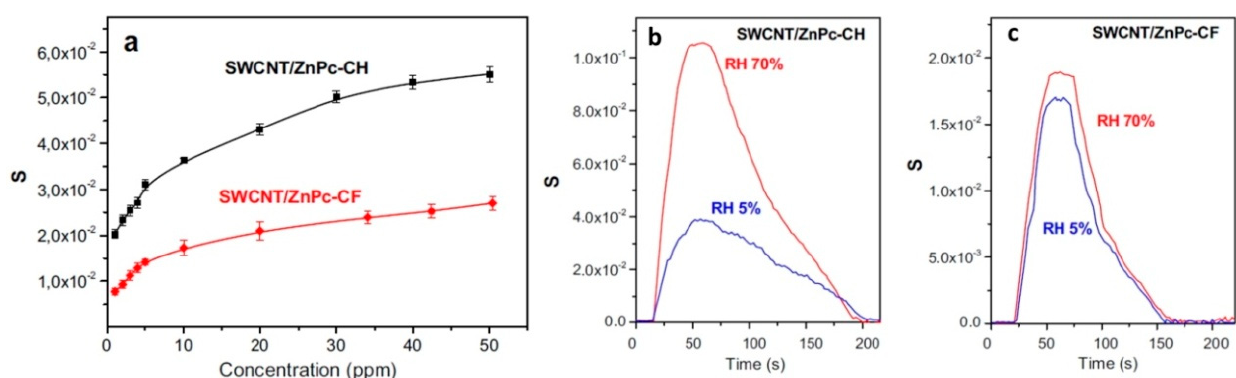
Figure 13. Dependence of the sensor response of SWCNT/ZnPc-CH and SWCNT/ZnPc-CF layers on ammonia concentration from 1 to 50 ppm ( a ). Sensor response of SWCNT/ZnPc-CH ( b ) and SWCNT/ZnPc-CF ( c ) hybrid layers to ammonia (10 ppm) measured at RH 5% and 70%. Reprinted from [86] with permission from Springer Nature.